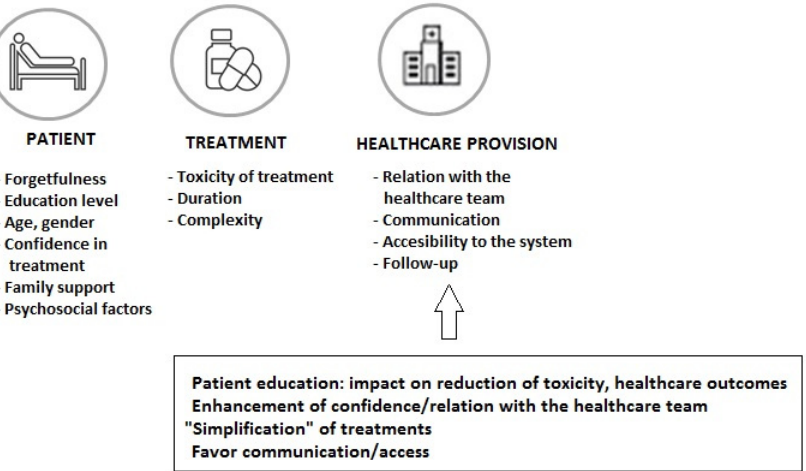
Figure 3. Factors related to the patient, the cancer treatment, and the healthcare system involved in non-adherence to oral anticancer